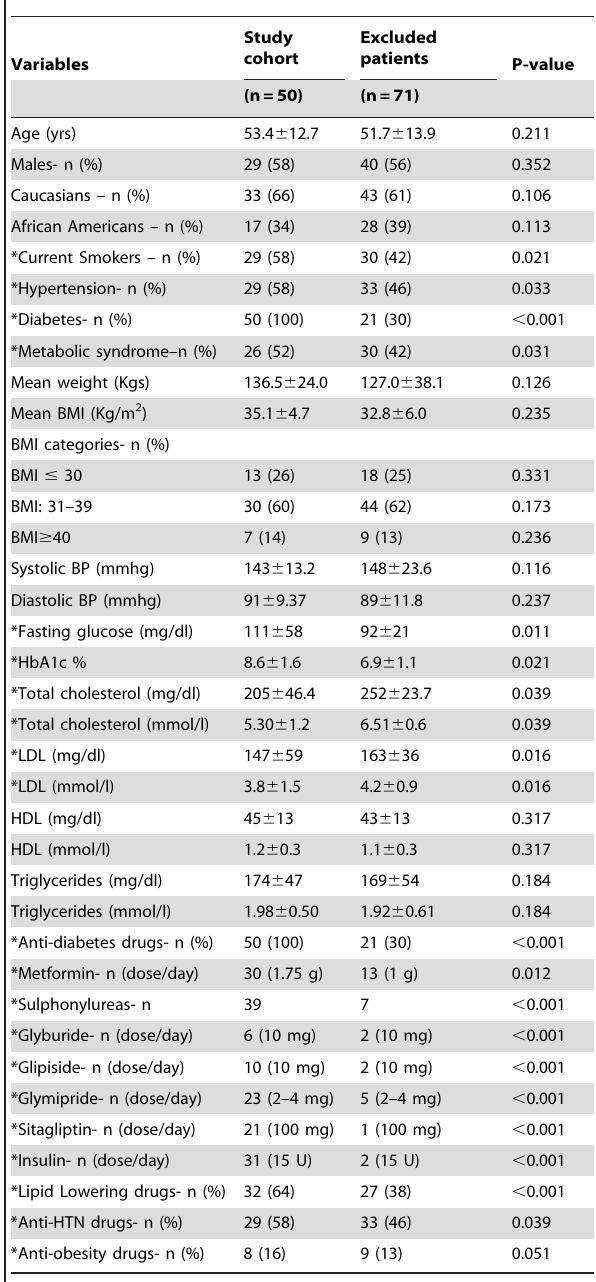
Table 1. Baseline comparison between included patients (study cohort) and excluded